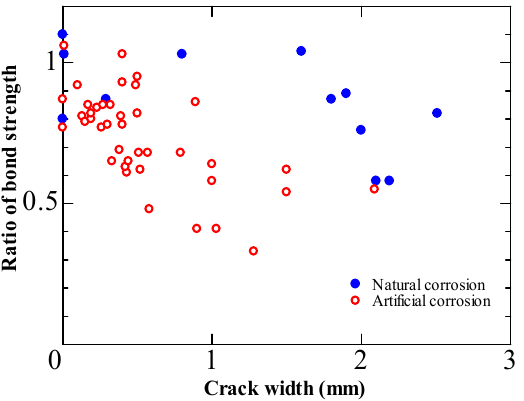
Figure 19. Influence of corrosion rate on the deterioration of bond strength [17].